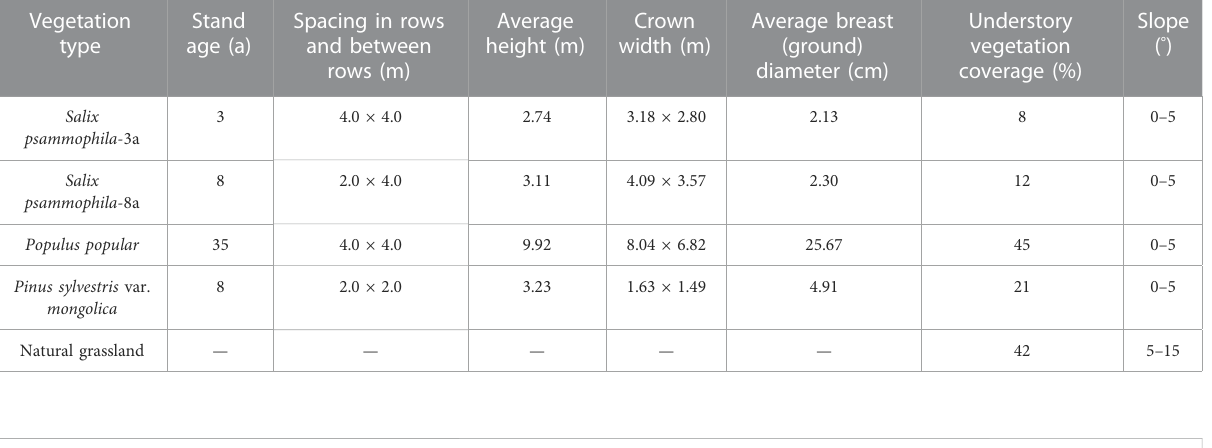
TABLE 1 General characteristics of the vegetation sample plots.